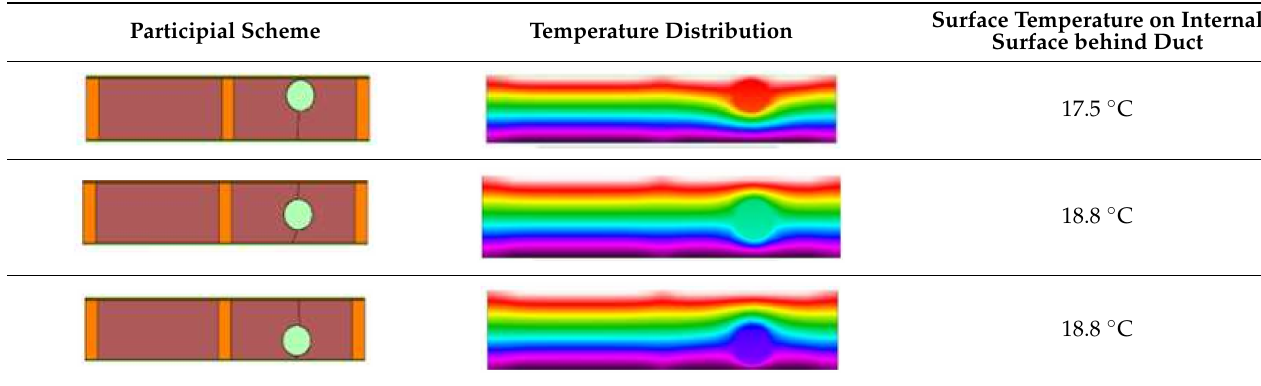
Table 3. Effect of integrated duct on light weight construction performance.